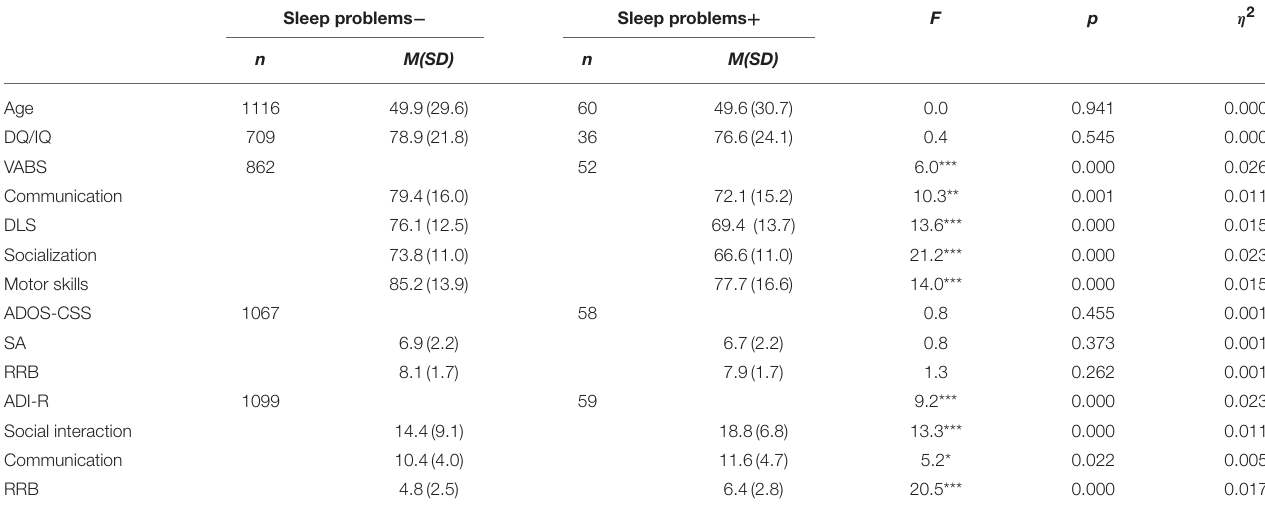
TABLE 5 | Mean and SD of cognitive scores, VABS scores and autism severity measures for the groups with and without sleep problems. Sleep problems − Sleep problems